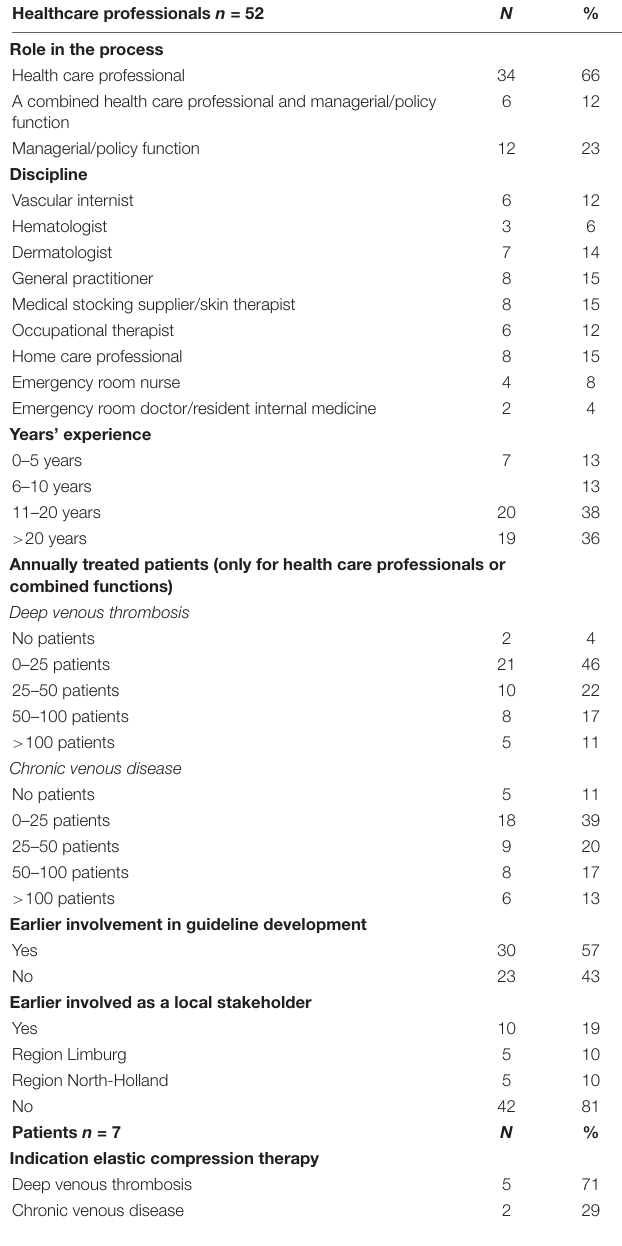
TABLE 1 | Background characteristics of the participants responding in the first